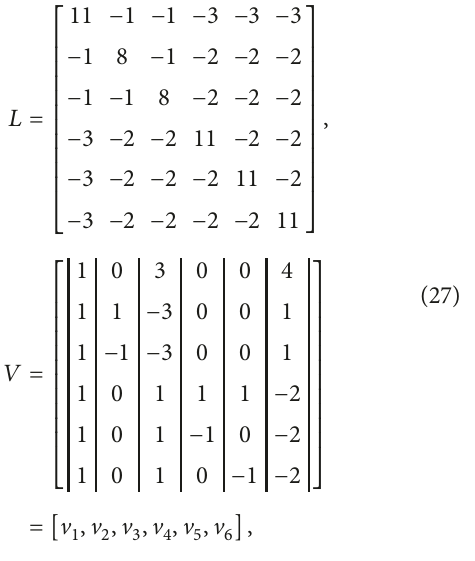
Figure 5. The corresponding Laplacian 𝐿 is